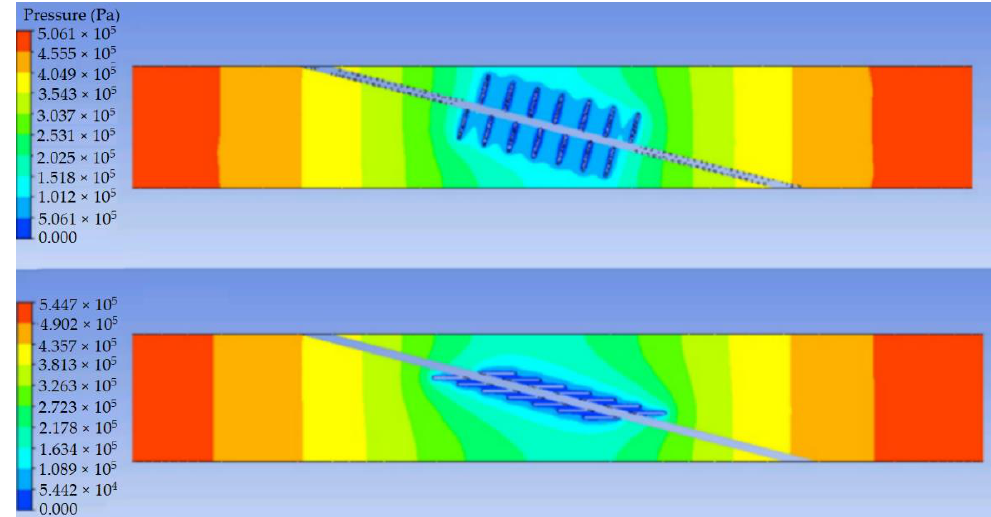
Figure 13. Numerical results for the pressure gradient through the near-wellbore region for two scenarios with maximum inclination angle 75°, 𝑄 = 2 L/min, 𝐿 𝑝 = 60.96 cm, and 𝑛 𝑝 = 1 perfora- tion/30.48 cm).